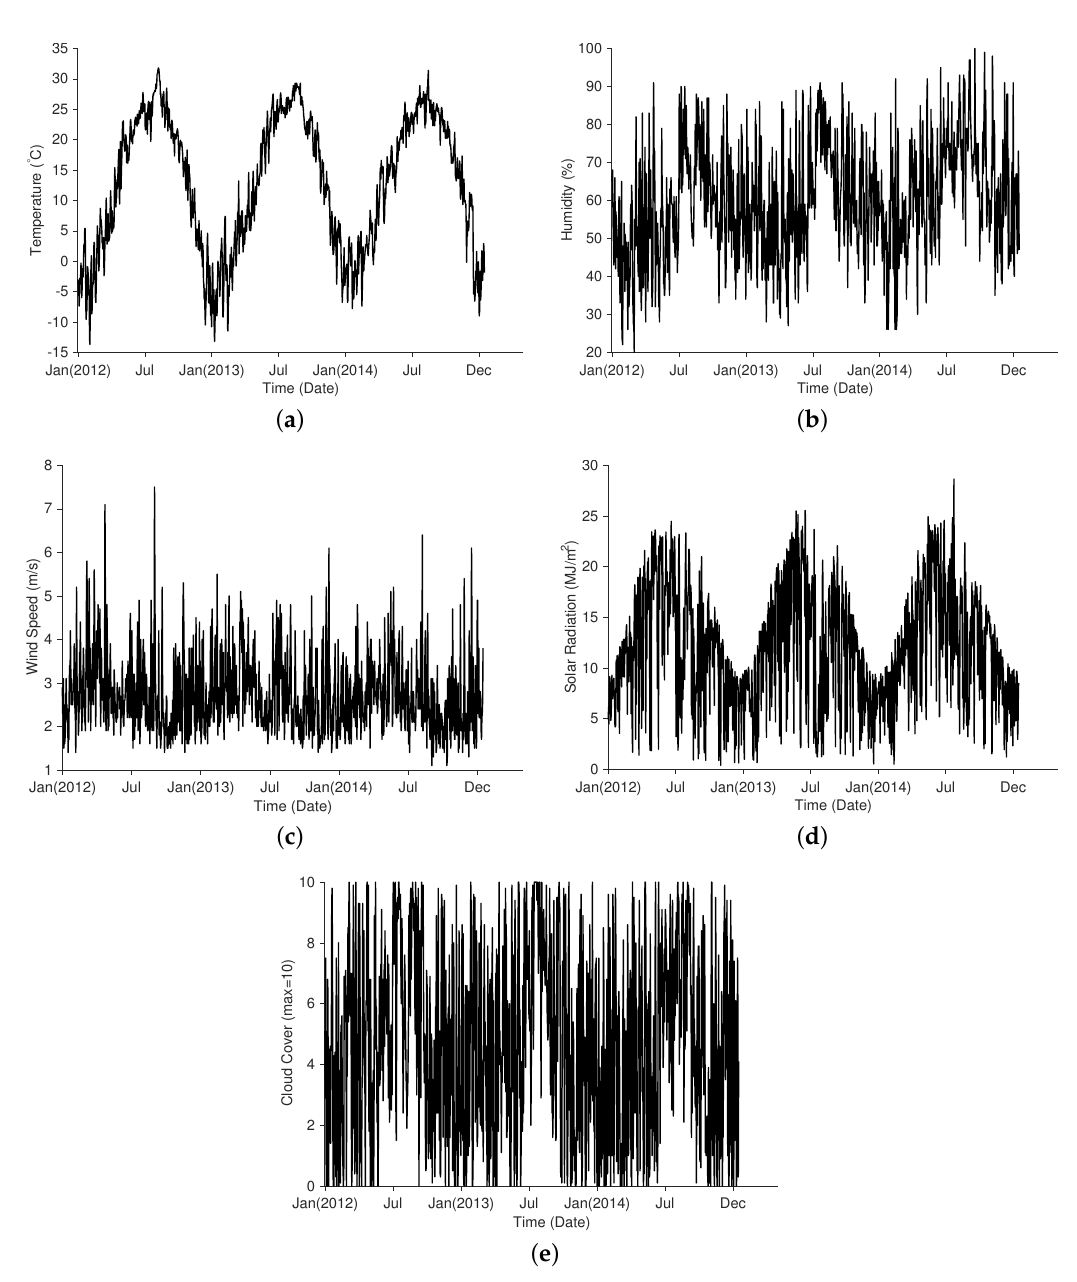
Figure 7. Weather variation in Korea: ( a ) Average temperature; ( b ) Humidity; ( c ) Wind speed; ( d ) Solar radiation; ( e ) Cloud